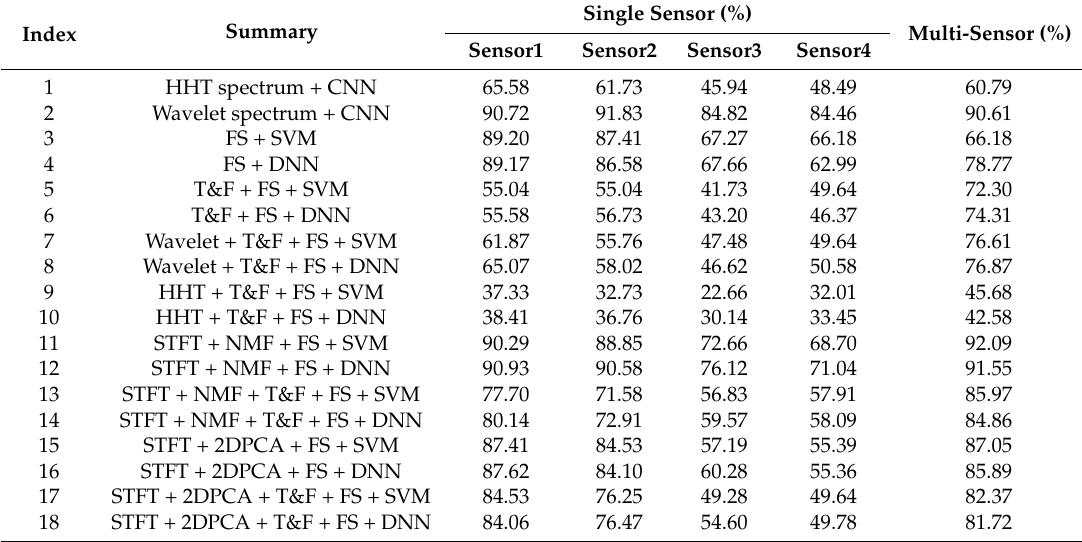
Table 6. Diagnostic accuracies of the baseline methods for classifying both defect types and